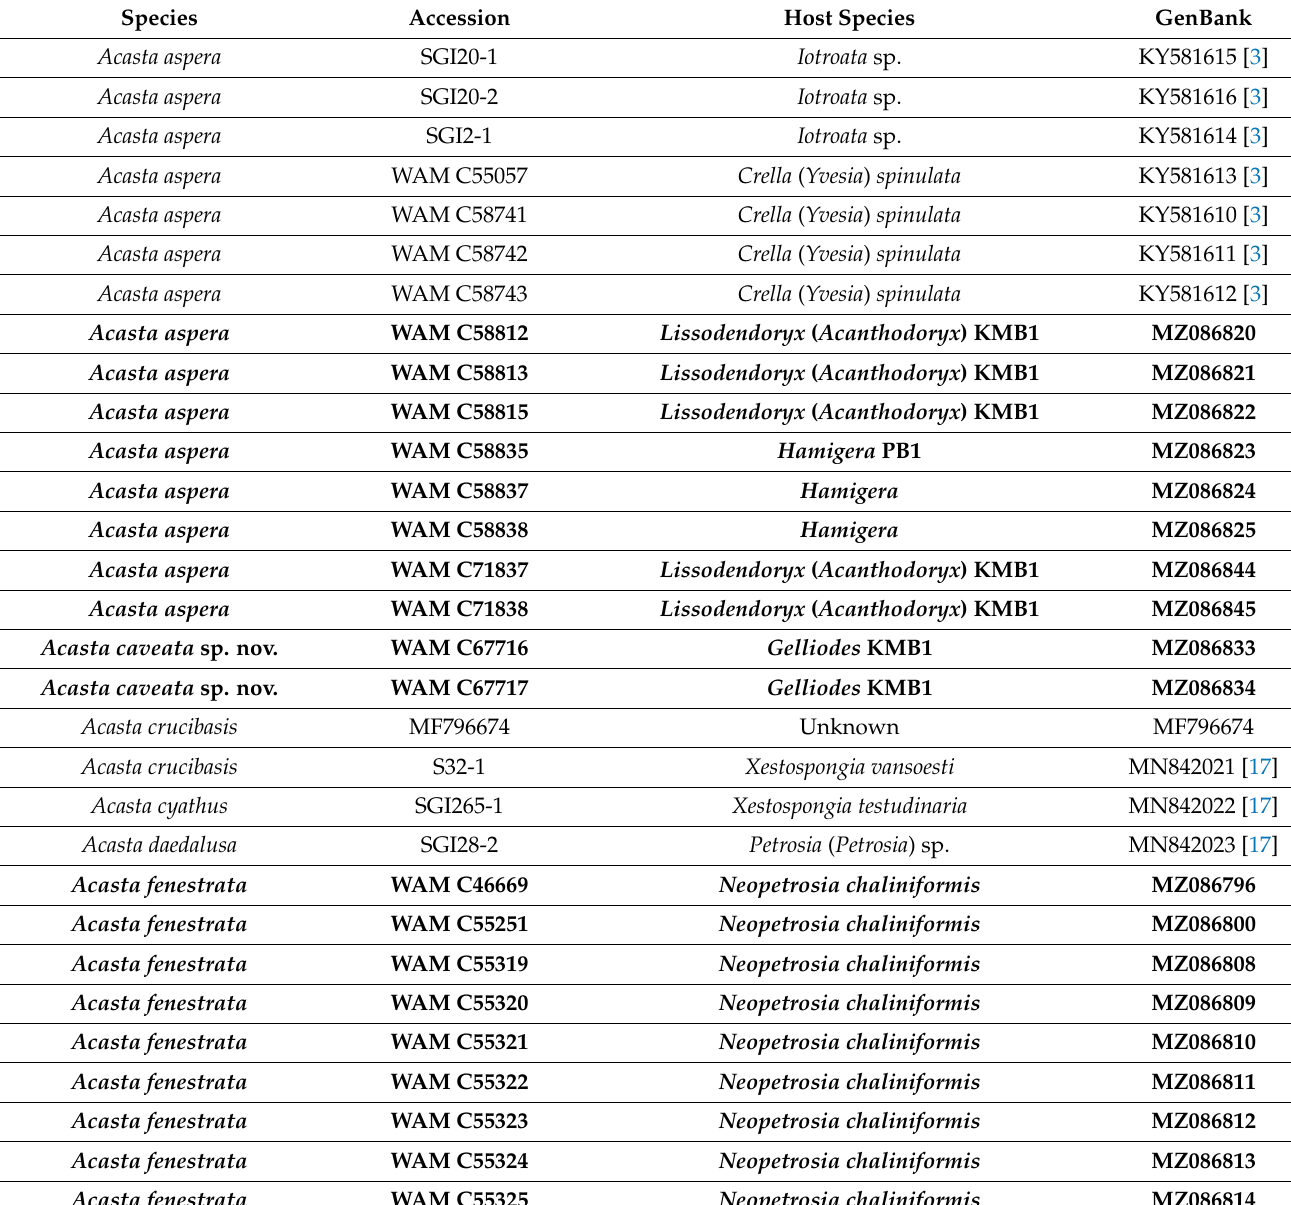
Table 1. Specimen details of sequences used in the molecular analysis. Records in bold indicate specimens newly sequenced for this